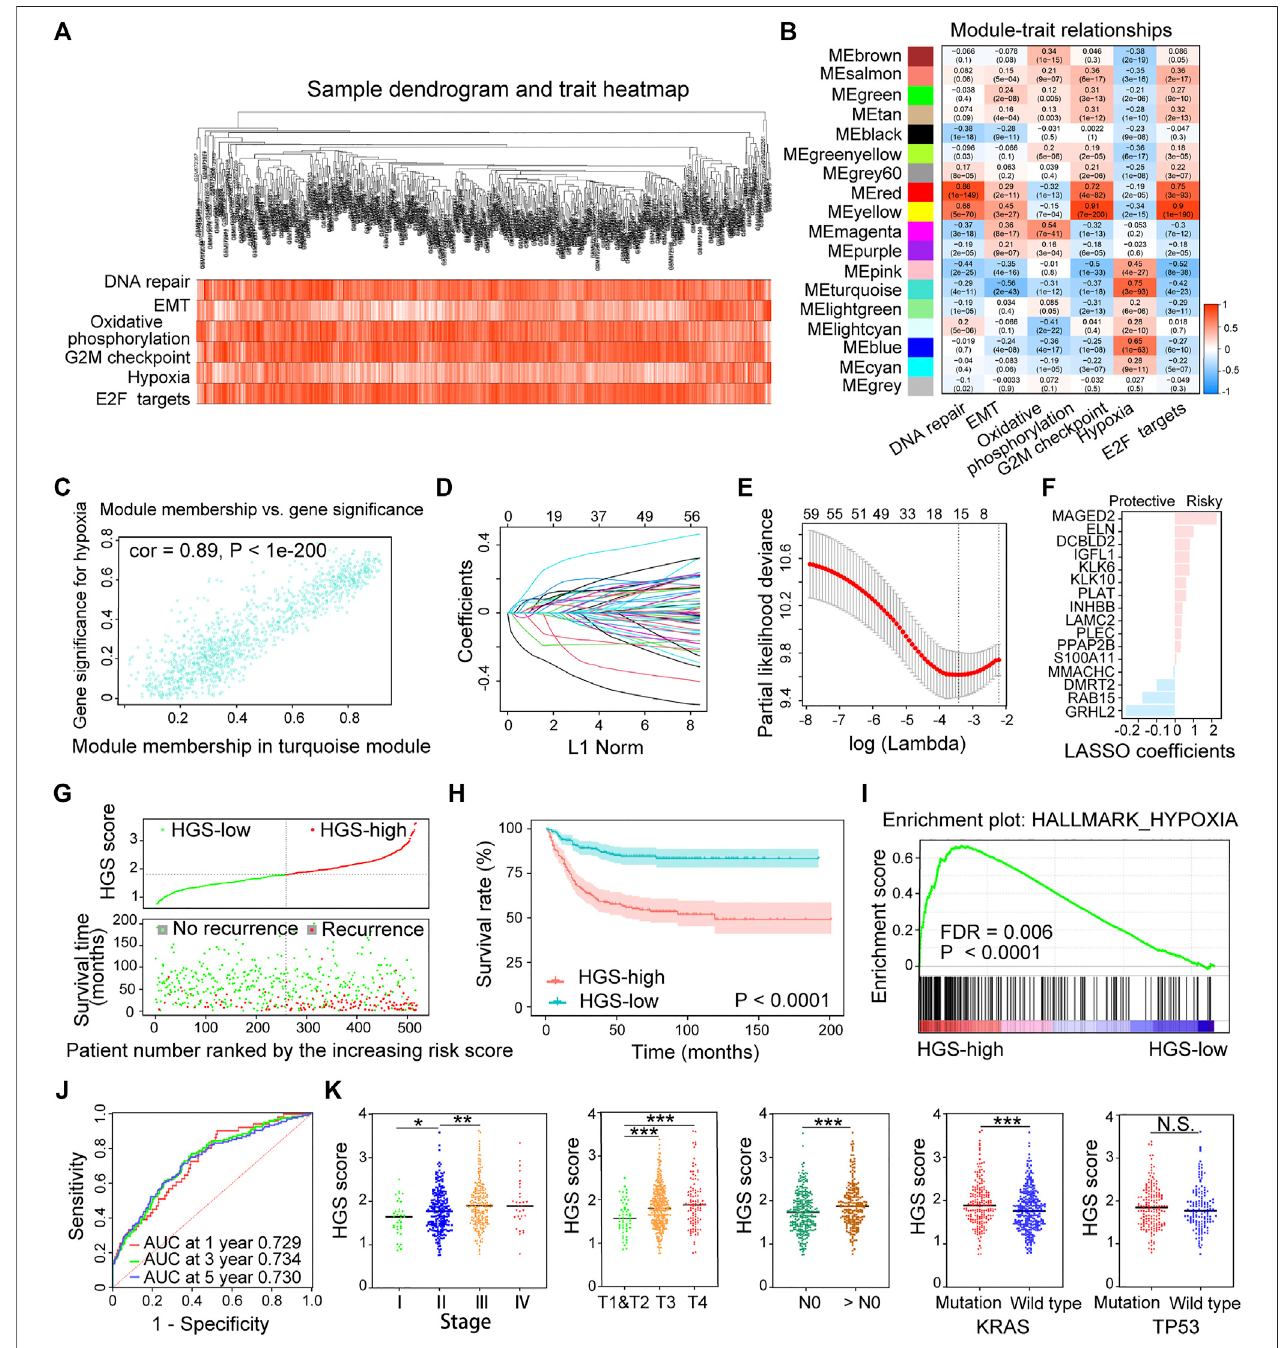
FIGURE 2 | Establishment and validation of HGS in the training cohort. (A) Clustering dendrogram of 518 samples from WGCNA. (B) Heatmap of the correlation between the modules and cancer hallmarks. (C) Correlation between turquoise module and hypoxia. (D) LASSO coef fi cient pro fi les of the hypoxia-related prognostic differential expressed genes. (E) 10-fold cross-validation for penalty parameter λ selectioninthe LASSO model. (F) LASSOcoef fi cients ofthe 16hypoxia-related genes. (G) Thedistribution ofHGSscore,patients ’ status andRFStime. (H) Kaplan – MeierRFScurvesforpatientsinHGS-highandHGS-lowgroups. (I) GSEAofhypoxia pathway in HGS-high and HGS-low groups. (J) Time-dependent ROC curves at 1, 3 and 5 years. (K) Correlation of HGS with clinicopathological characteristics.